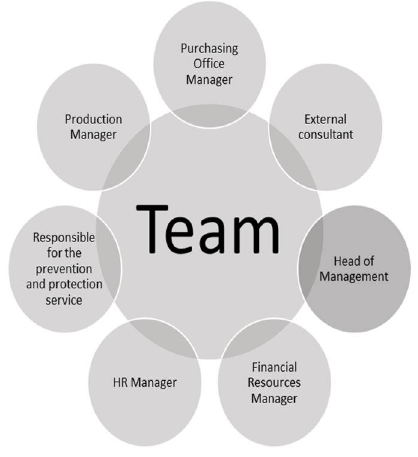
Figure 4. Team composition.